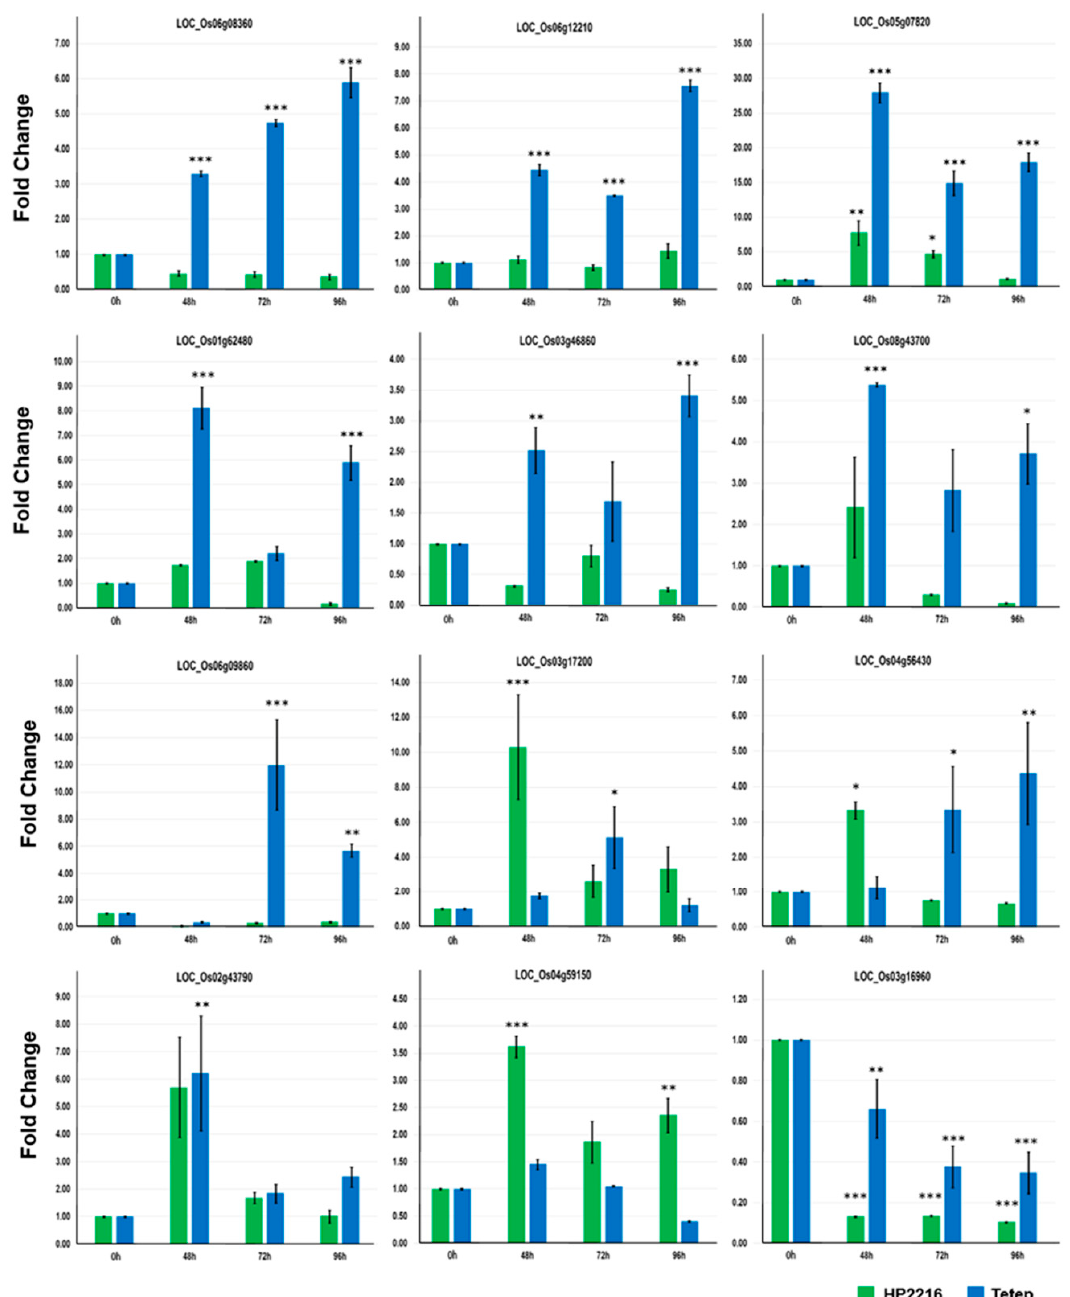
Figure 4. qRT-PCR validation of selected differentially expressed genes. qRT-PCR validation of significant differentially expressed loci (SDEL) in HP2216 and Tetep upon M. oryzae infection. The green and blue bars represent the absolute fold change of HP2216 and Tetep, respectively. 18s was used for transcript normalization. Standard error bar shows the standard deviation for three replicate assays. LOC_Os06g08360 (ethylene-responsive element-binding protein), LOC_Os06g12210 (helix-loop-helix DNA-binding domain containing protein), LOC_Os05g07820 (leucine-rich repeat receptor protein kinase EXS precursor), LOC_Os01g62480 (laccase precursor protein), LOC_Os03g46860 (helix-loop-helix DNA-binding protein), LOC_Os08g43700 (OsSAUR36 –small Auxin-responsive SAUR gene family member), LOC_Os06g09860 (expressed protein), LOC_Os03g17200 (plant-specific domain TIGR01589 family protein), LOC_Os04g56430 (cysteine-rich receptor-like protein kinase), LOC_Os02g43790 (ethylene-responsive transcription factor), LOC_Os04g59150 (peroxidase precursor), LOC_Os03g16960 (cysteine-rich repeat secretory protein 55 precursor).